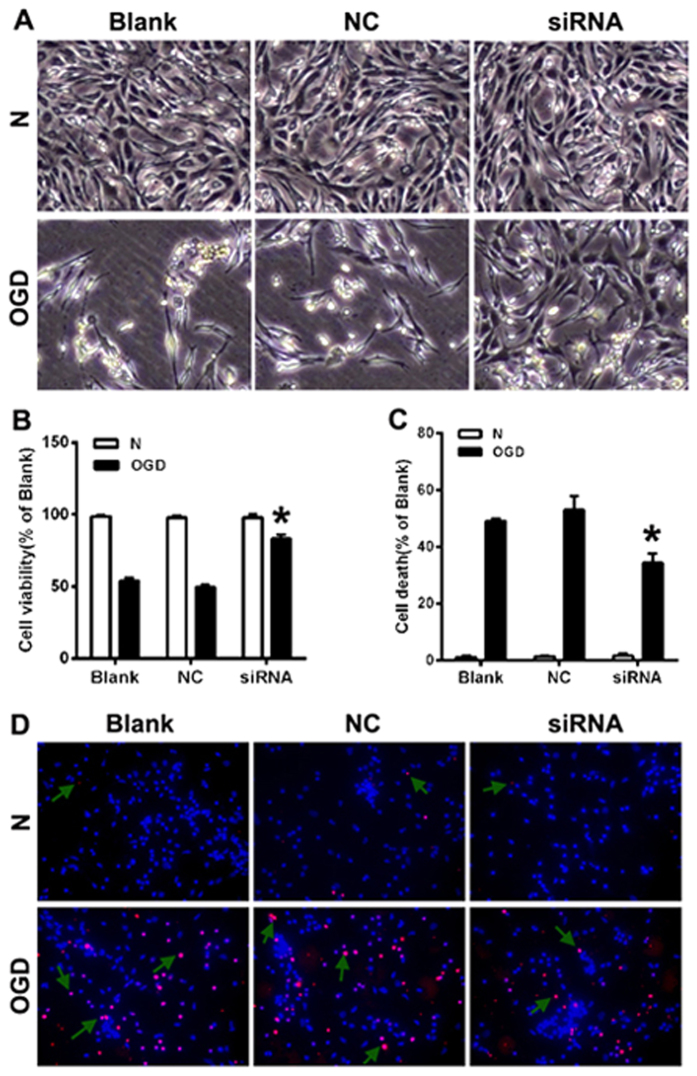
Silencing of BC088414 promoted proliferation and suppressed apoptosis in OGD treated PC12 cells.(A) Morphological observation of cell growth state. Following OGD, the numbers of PC 12 cells were reduced. Compared with Blank and NC groups, the number of living cells in siRNA group was increased. (B) CCK8 cell proliferation assay in PC 12 cells. The cell viability of PC12 cells was decreased after OGD. SiRNA transfection induced higher growth rate compared to Blank and NC. (C,D) TUNEL staining in PC12 cells. The apoptosis cells were increased after OGD. Knockdown of BC088414 in PC12 cells reduced apoptosis induced by OGD. Arrows shows positive staining cells. *P < 0.05 versus Blank group. Blank: non-transfected group; NC: nonsense siRNA transfected group; siRNA: siRNA transfected PC12 cells; N: normoxia; OGD: oxygen and glucose deprivation.